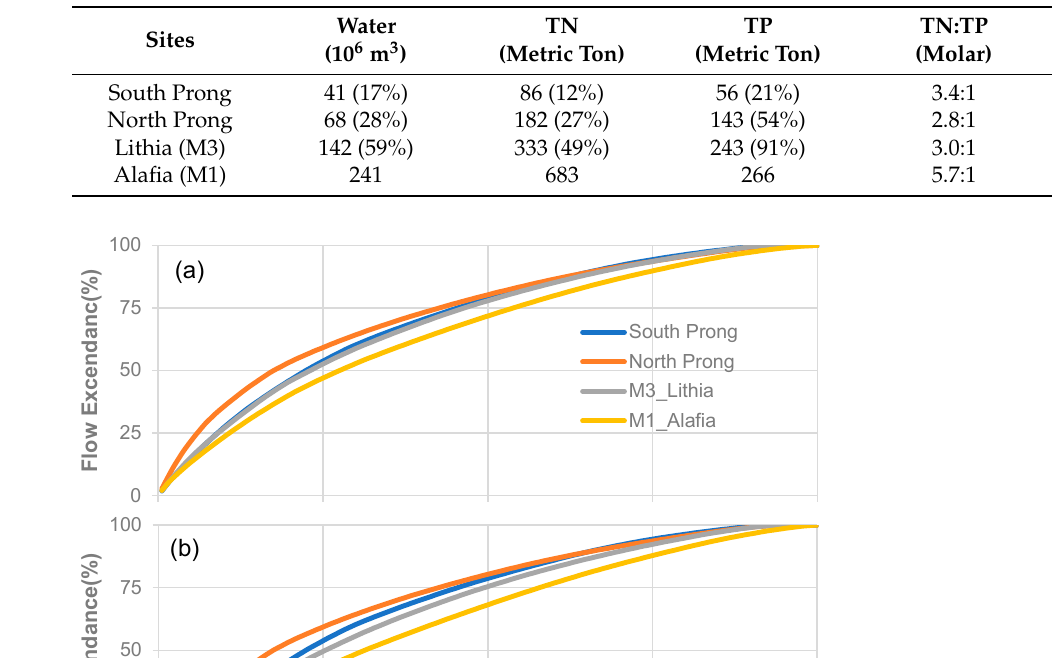
Table 2. Water discharge, loads of total nitrogen (TN) and total phosphorus (TP), and molar ratio of TN:TP in the South Prong, North Prong, mainstem site M3 at Lithia, and mainstem site M1 at Alafia with decreasing phosphate-mining areas.